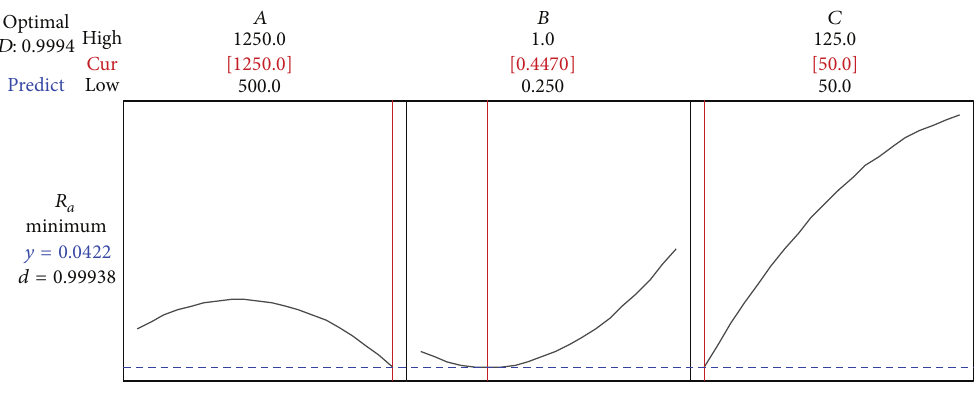
Figure 7: Optimization plot for 𝑅 𝑎 .